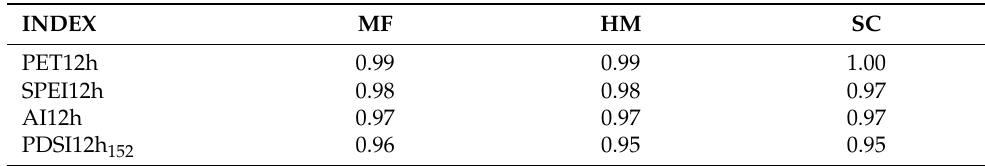
Table 1. Correlation coefficients between on-site vs. PRISM meteorologically parameterized drought indices at each site (MF, HM, and SC). PET and all drought indices were calculated on an annual basis over the hydrologic year (10/1 through